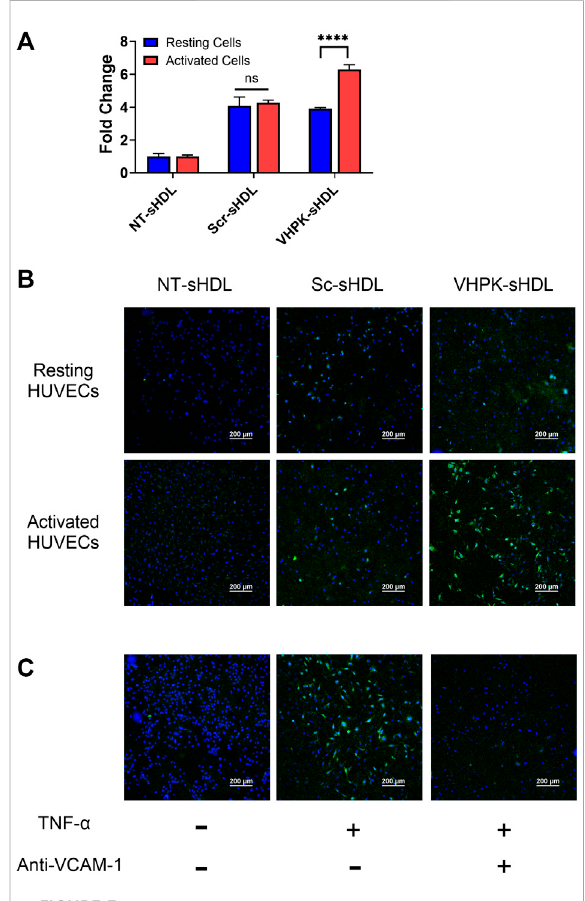
FIGURE 3 (A) Cellular binding of different sHDLs on resting and activated HUVEC cells evaluated by fl ow cytometry ( n = 3, mean ± SD. **** p < 0.001). (B,C) Representative confocal microscope images of cellular binding of sHDLs on HUVEC monolayers. Blue: Nucleus; Green: DiD-labeled sHDLs.